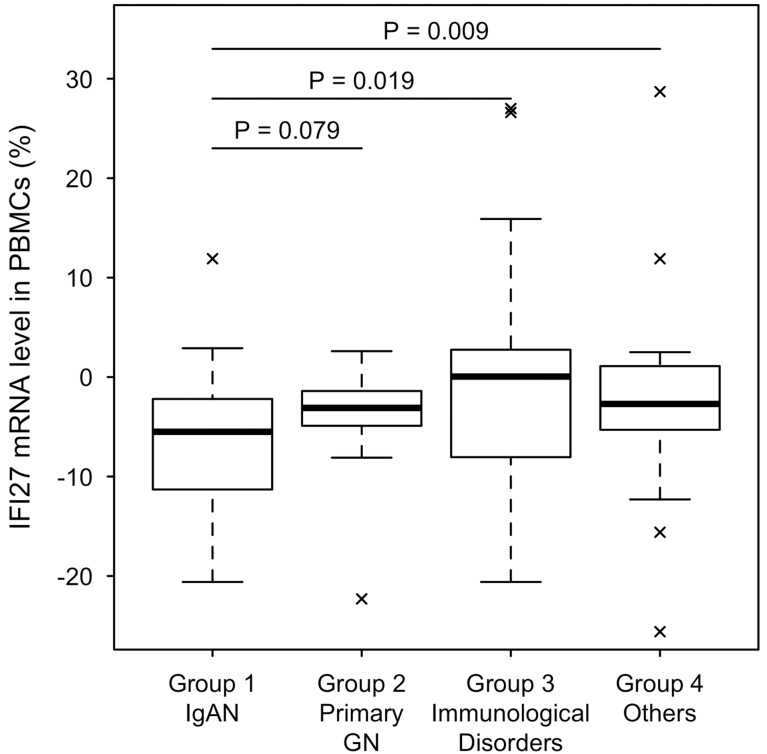
Statistical analysis of IFI27 mRNA levels in PBMCs of various chronic glomerulonephritis patients, divided into four groups.Group 1: IgAN (n = 64), Group 2: Primary GN (n = 27), Group 3: Immunological Dis (n = 20), Group 4: Others (n = 34). TN2 and DIIG1 were plotted outside the figure because of their remarkably high IFI27 mRNA levels (52.6% and 190.2%, respectively). IgAN, IgA nephropathy; Primary GN, primary glomerulonephritis; Immunological Dis, secondary glomerulonephritis due to immunological disorders; Others, other kidney diseases.